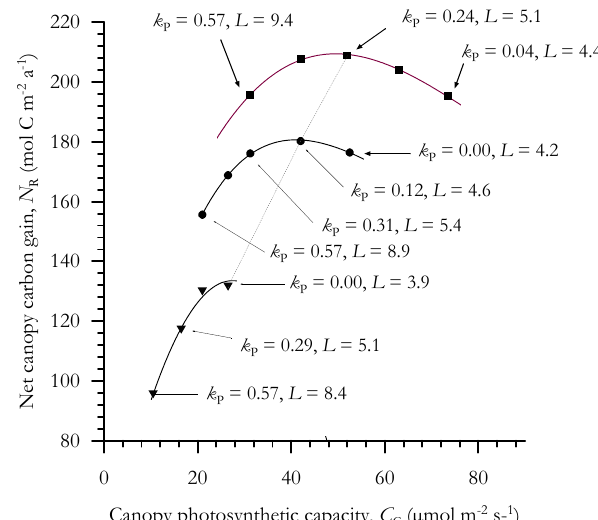
Fig. 4. Relationship between net canopy carbon gain (as de- fined by Eq. 2) and canopy photosynthetic capacity according to the model presented in Appendix A and Sect. 2. Curves shown are for different photosynthetic capacities, A ∗ , at the top of the 0 canopy; t : A ∗ =6µmolm − 2 s − 1 ; l : A ∗ =12µmolm − 2 s − 1 ; n : 0 0 A ∗ =18µmolm − 2 s − 1 0